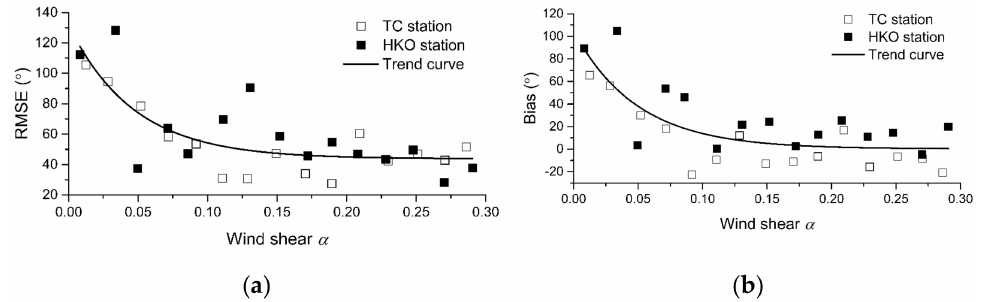
Figure 14. Wind direction error variation as a function of the α . ( a ) RMSE of wind direction; ( b ) Bias of wind